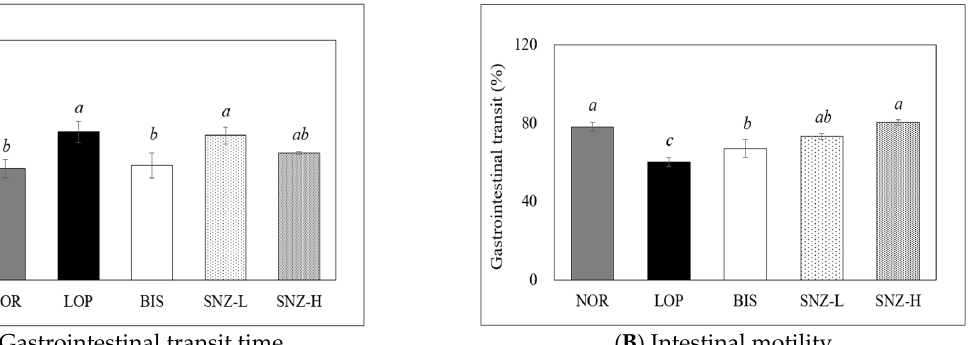
Figure 3. Effects of B. coagulans SNZ 1969 on ( A ) gastrointestinal transit time and ( B ) intestinal mo- tility. NOR: Normal group; LOP: Loperamide treated group; BIS: Loperamide and Bisacodyl 8 mg/kg treated group; SNZ-L: Loperamide and B. coagulans SNZ 1969 at 1 × 10 8 CFU/day treated group; SNZ-H: Loperamide and B. coagulans SNZ 1969 at 1 × 10 10 CFU/day treated group. Results are presented as Mean ± SE (n = 8). Means with the different letters above a bar are significantly different at p < 0.05 by Duncan’s multiple range test.